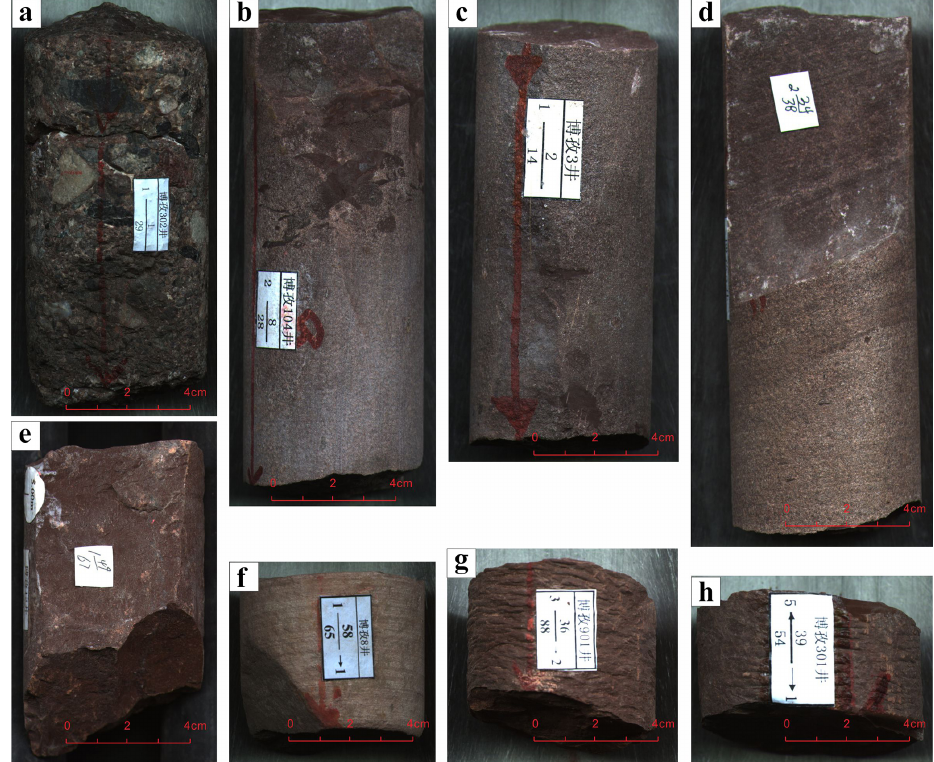
Figure 3. Core photos showing the lithologies of Cretaceous Bashijiqike Formation in Kuqa Depression. (a) Conglomerates, Bozi 302. (b) Pebbly sandstones, Bozi 104. (c) Medium-grained sandstone, Bozi 3. (d) Fine-grained sandstones, Bozi 3. (e) Siltstones, Bozi 12. (f) Siltstones, Bozi 8. (g) Mudstones, Bozi 901. (h) Mudstones, Bozi